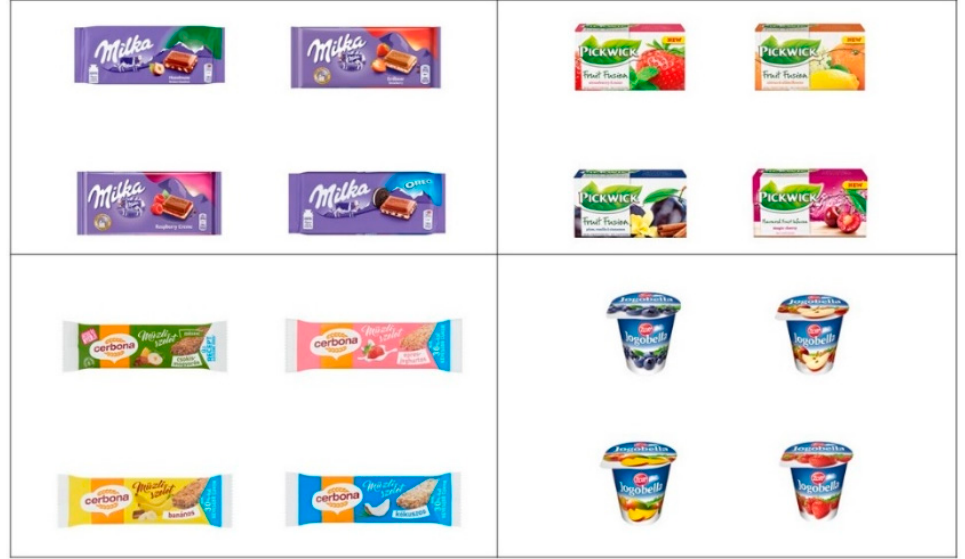
Figure 1. The four presented choice sets from top left to bottom right: chocolate, tea, muesli bar,